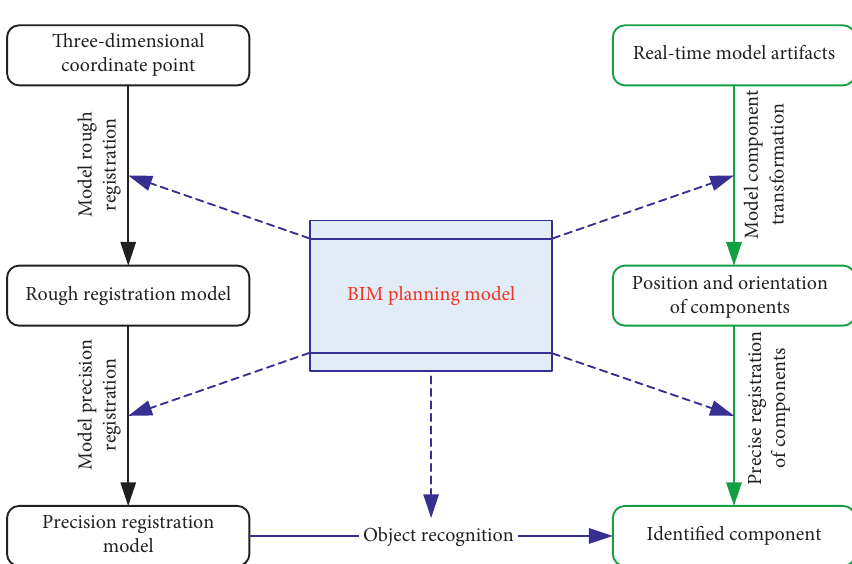
Figure 2: BIM real-time model creation process based on planning